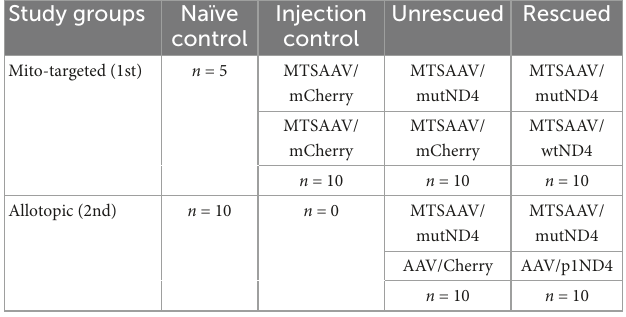
Table 1 . For the treatment, the mice were first injected with mutant human ND4, and 2 days later were injected with wildtype human ND4 (Rescued) or m/Cherry (un-rescued). The injection controls received two injections of mCherry. Pattern electroretinograms (PERGs) were performed longitudinally at 3-, 6-, 9-, and 12-month after injections for the allotopic group and baseline, 1-, 3-, 6-, and 12-month after injection for the mito-targeted group.